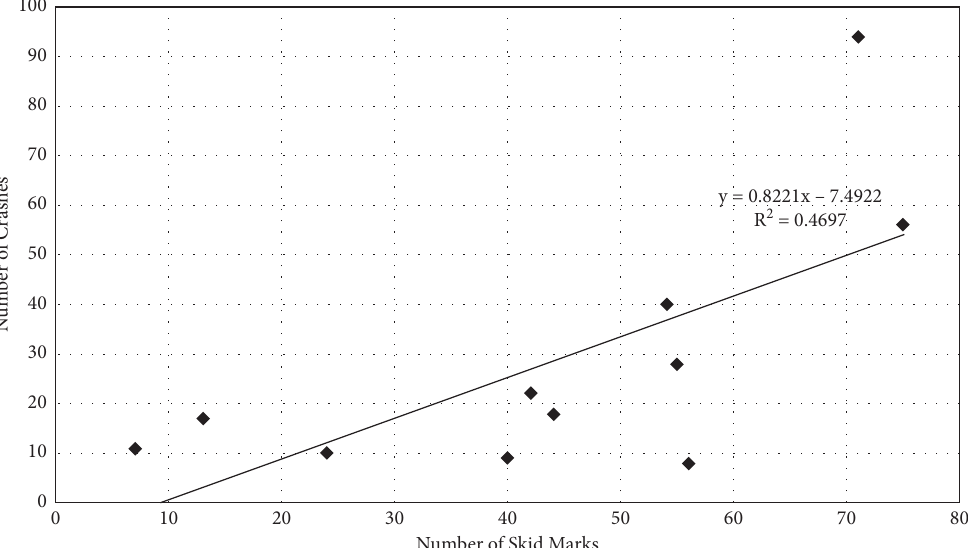
Figure 7: Crash vs. skid correlation by 1-mile segments on Interstate 80 eastbound.